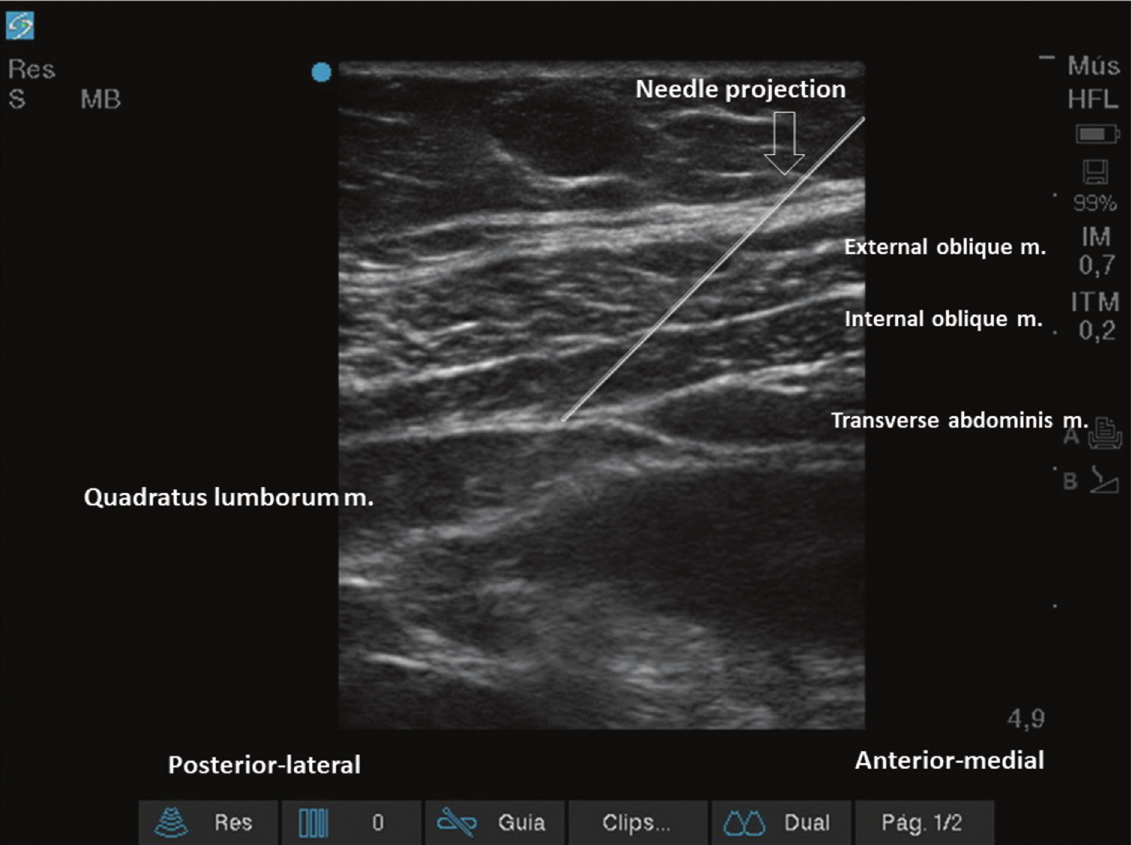
Figure 17 - US image, with needle projection. Its tip is located on the posterior-lateral border of the TA muscle, posterior to the QL muscle.